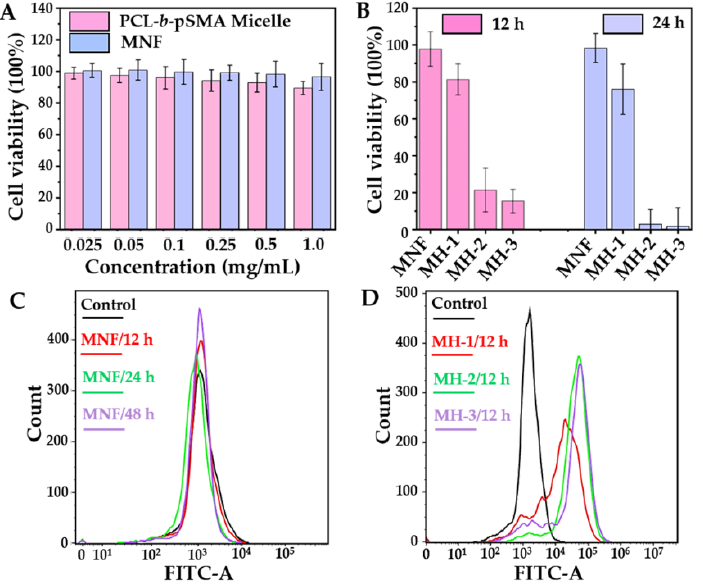
Figure 7. Cellular experiments on the biological effect of the MNF and MH, including the ( A ) biocompatibility of the PCL- b -pSMA micelles and MNF; ( B ) MH-induced cell death; intercellular ROS generation by ( C ) MNF ( D ) and MH.